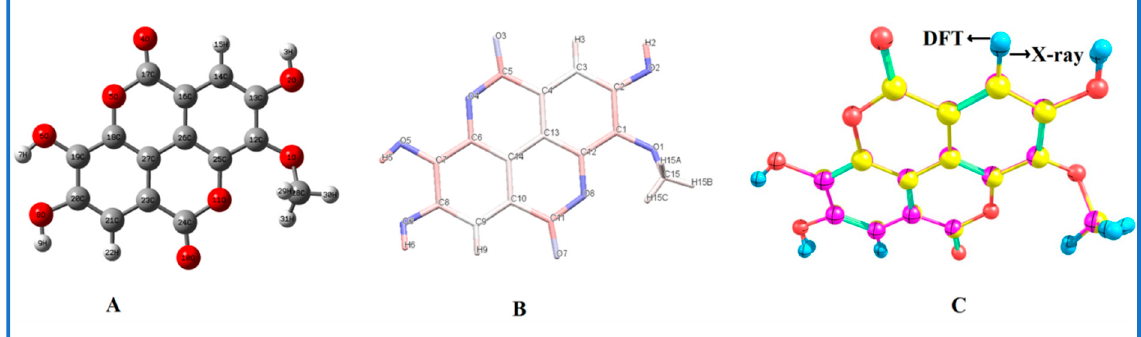
Figure 3. ( A – C ). ( A ) Optimized geometry ( B ) XRD of 3- O -methylellagic acid dihydrate ( 2 ) and ( C ) superposition of the optimized structure on the experimental structure atom by atom.